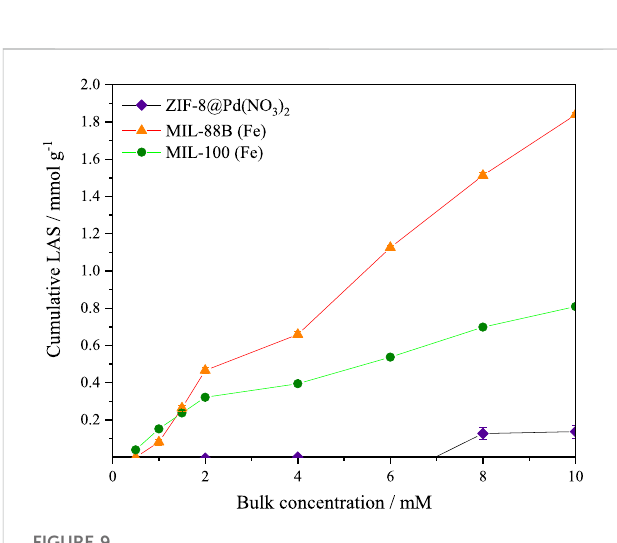
FIGURE 9 Adsorption of pyridine in cyclohexane by frontal analysis for the determination of acid site concentrations of ZIF-8@Pd(NO 3 ) 2 , MIL-100, and MIL-88B. Errors taken from standard deviation ( n = 3). Lines added for visualisation